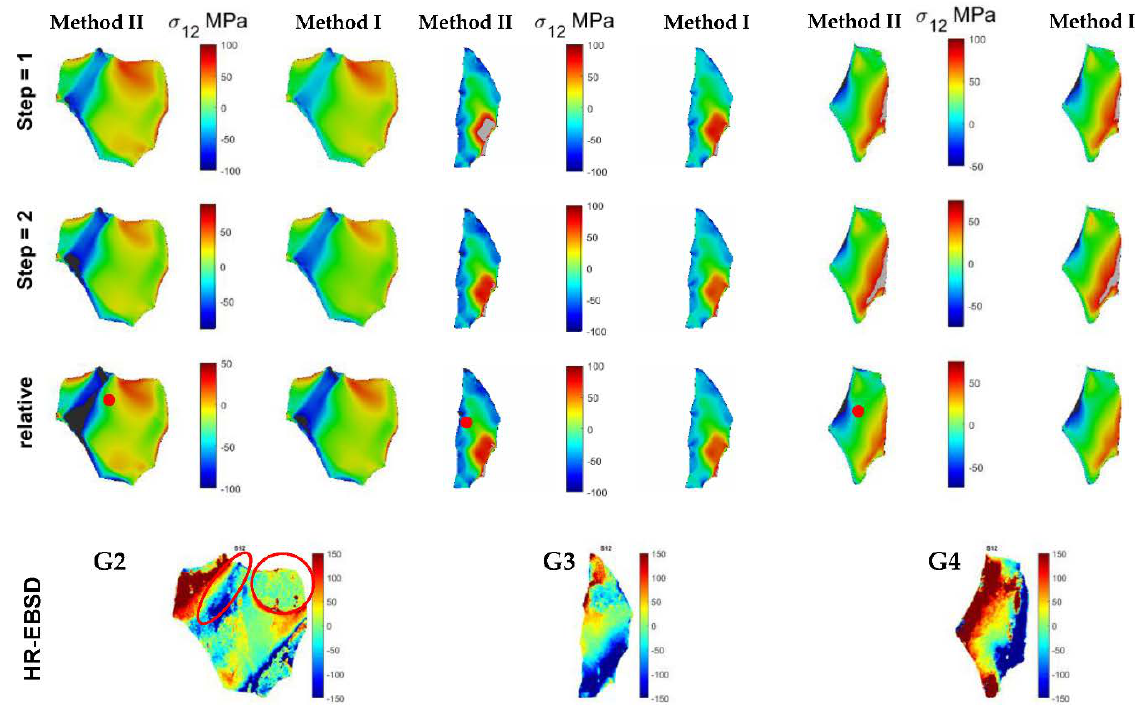
Figure 8. The in-plane shear stress component of grains G2, G3, and G4. A comparison between Method I ( right column ) and Method II ( left column ) of the CPFE model and HR-EBSD ( last row ).